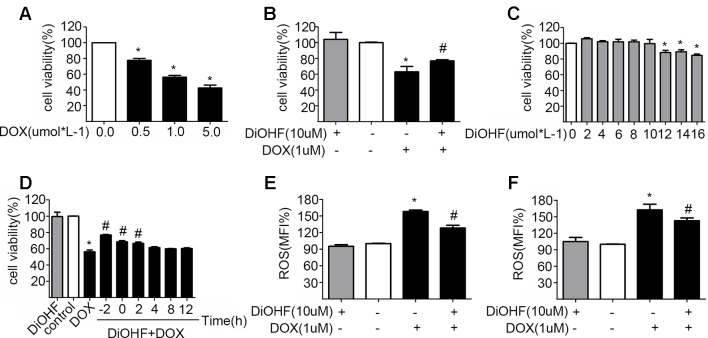
The protective effects of DiOHF on H9C2 cells against the DOX-induced cytotoxicity (A) DOX led to the reduction of cell viability in a dose-dependent manner (n = 3). (B) DiOHF inhibited the DOX-induced reduction of cell viability (n = 3). (C) Effects of different concentrations of DiOHF on cell viability (n = 3). (D) The H9C2 cells were treated with vehicle or DOX (1 µM for 24 h), and DiOHF was administrated at different time points (–2, 0, 2, 4, 8, and 12 h). Cell viability was determined using CCK-8 kit (n = 3). (E) Pre-treatment with DiOHF for 2 h reduced the DOX-induced ROS production (n = 3). (F) Post-treatment with DiOHF for 2 h also decreased the DOX-induced ROS production (n = 3). Data were analyzed by ANOVA and expressed as the mean ± SEM. *P < 0.05, compared with control. #
P < 0.05, compared with DOX.